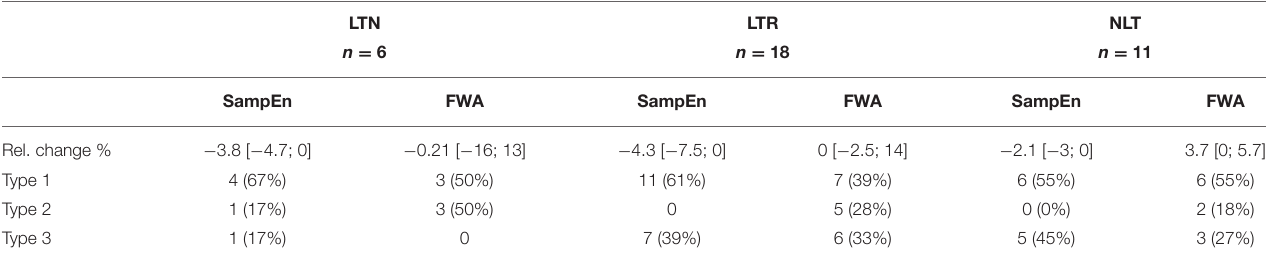
Patient counts and percentages of total count are indicated for each type of transition.